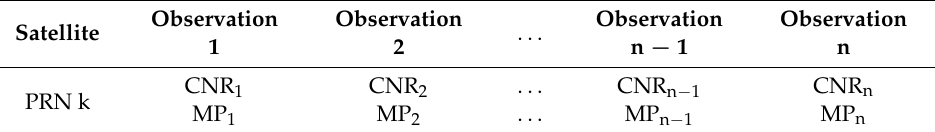
Table 1. Input time-series data structure; PRN denotes Pseudo Random Number. Satellite